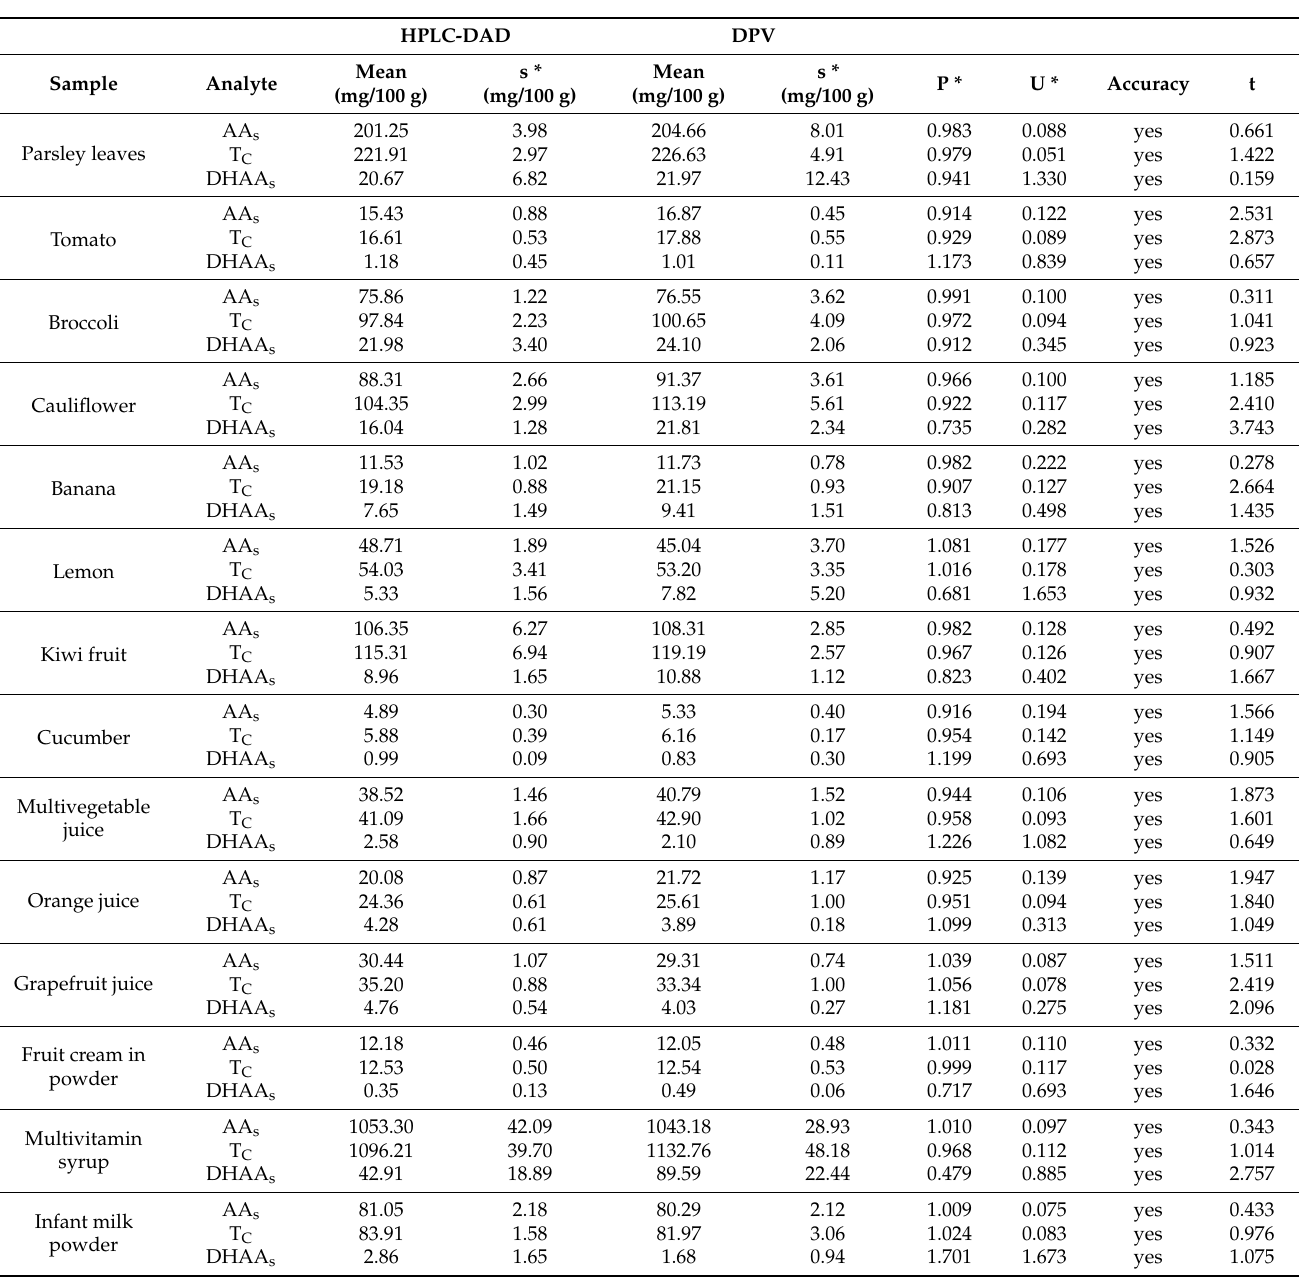
Table 4. Comparison of ascorbic acid, total vitamin C, and dehydroascorbic acid values obtained by differential pulse voltammetry (DPV) and chromatographic method (HPLC-DAD) (t cr = 2.776 for α =